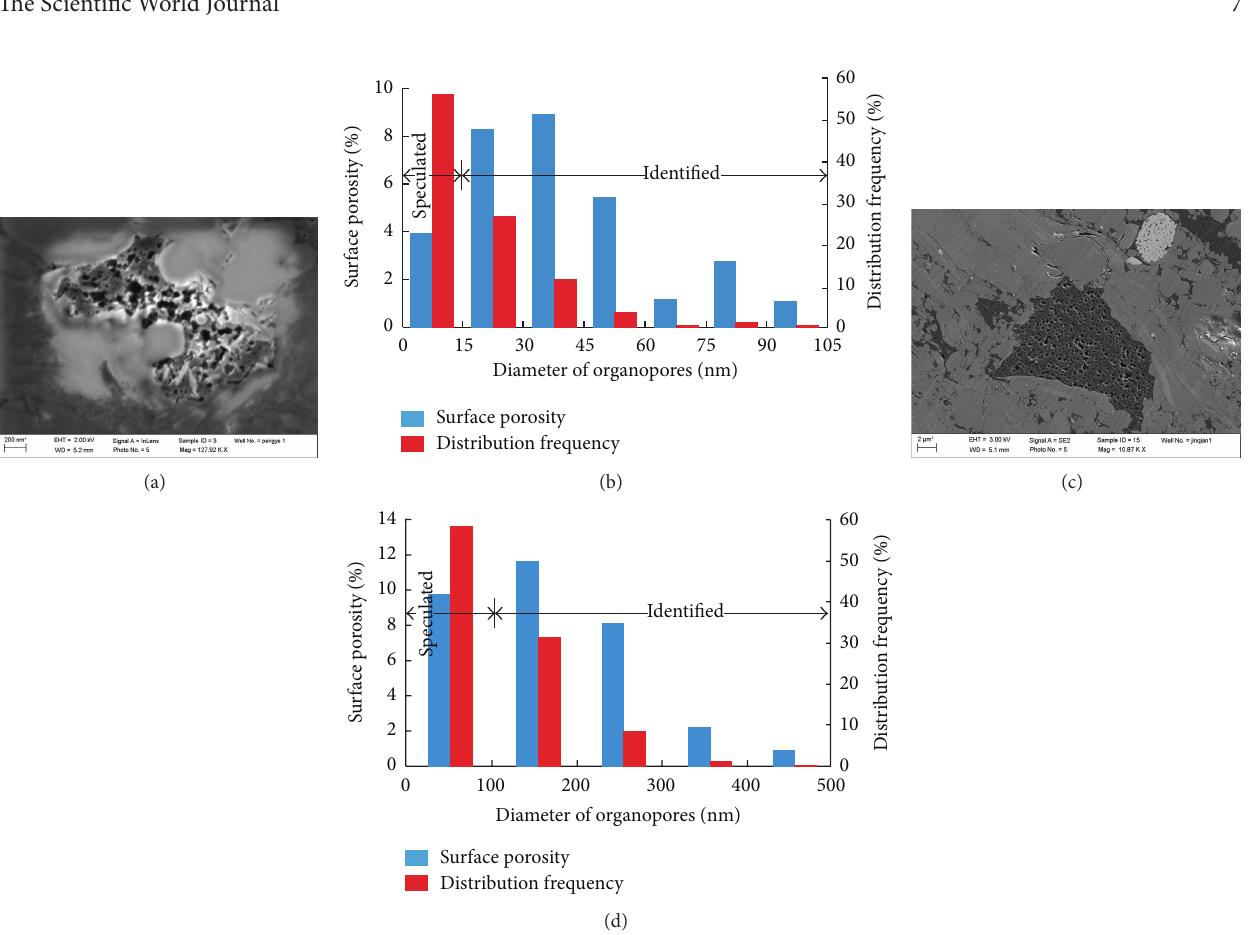
Figure 6: The organic surface porosity and distribution frequency of the Py1 well from Longmaxi Shale in southeast Chongqing. organopores were speculated. (3) Assuming that the uniden- tified organopores are approximate spheres, the contribution can be calculated of unidentified organopores to SP organic using the area formula of a